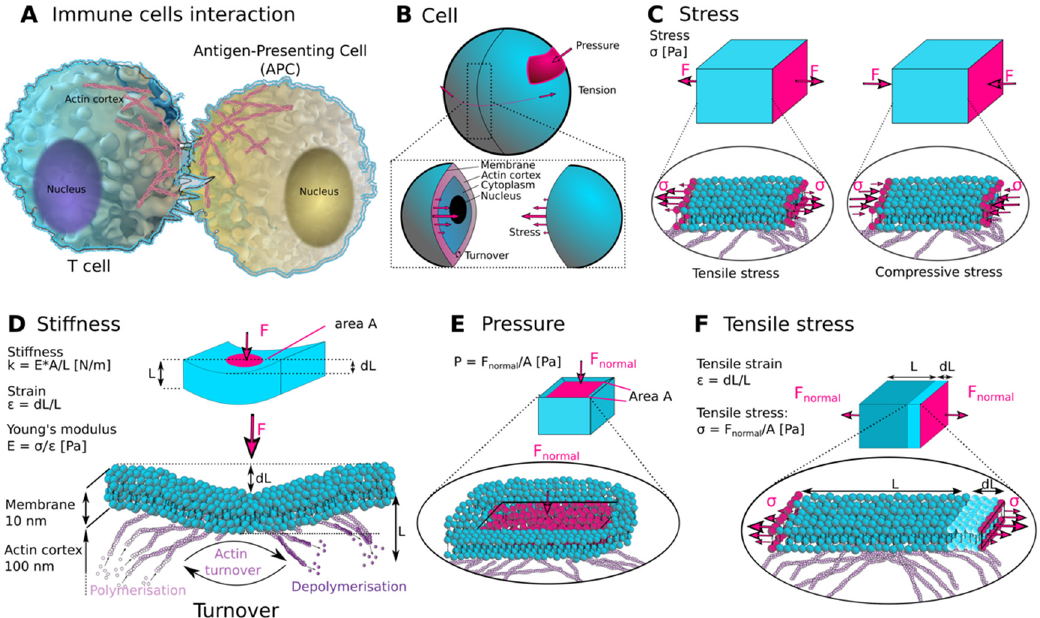
Figure 1. ( A ) Schematic of the interaction between a T cell and an antigen-presenting cell (APC). ( B ) Conceptual visualization of the main mechanical forces and parameters on a simplified spherical model of a cell. ( C – F ) Illustrations of the mechanical metrics of stress, stiffness, pressure and tensile stress on an example of a cuboidal homogenous body (upper panels) and placed into cellular context by cartoons of the membrane-cortex in the lower panels. In ( D , F ), the mathematical definitions for stiffness, strain, Young’s modulus, tensile strain and tensile stress are given.